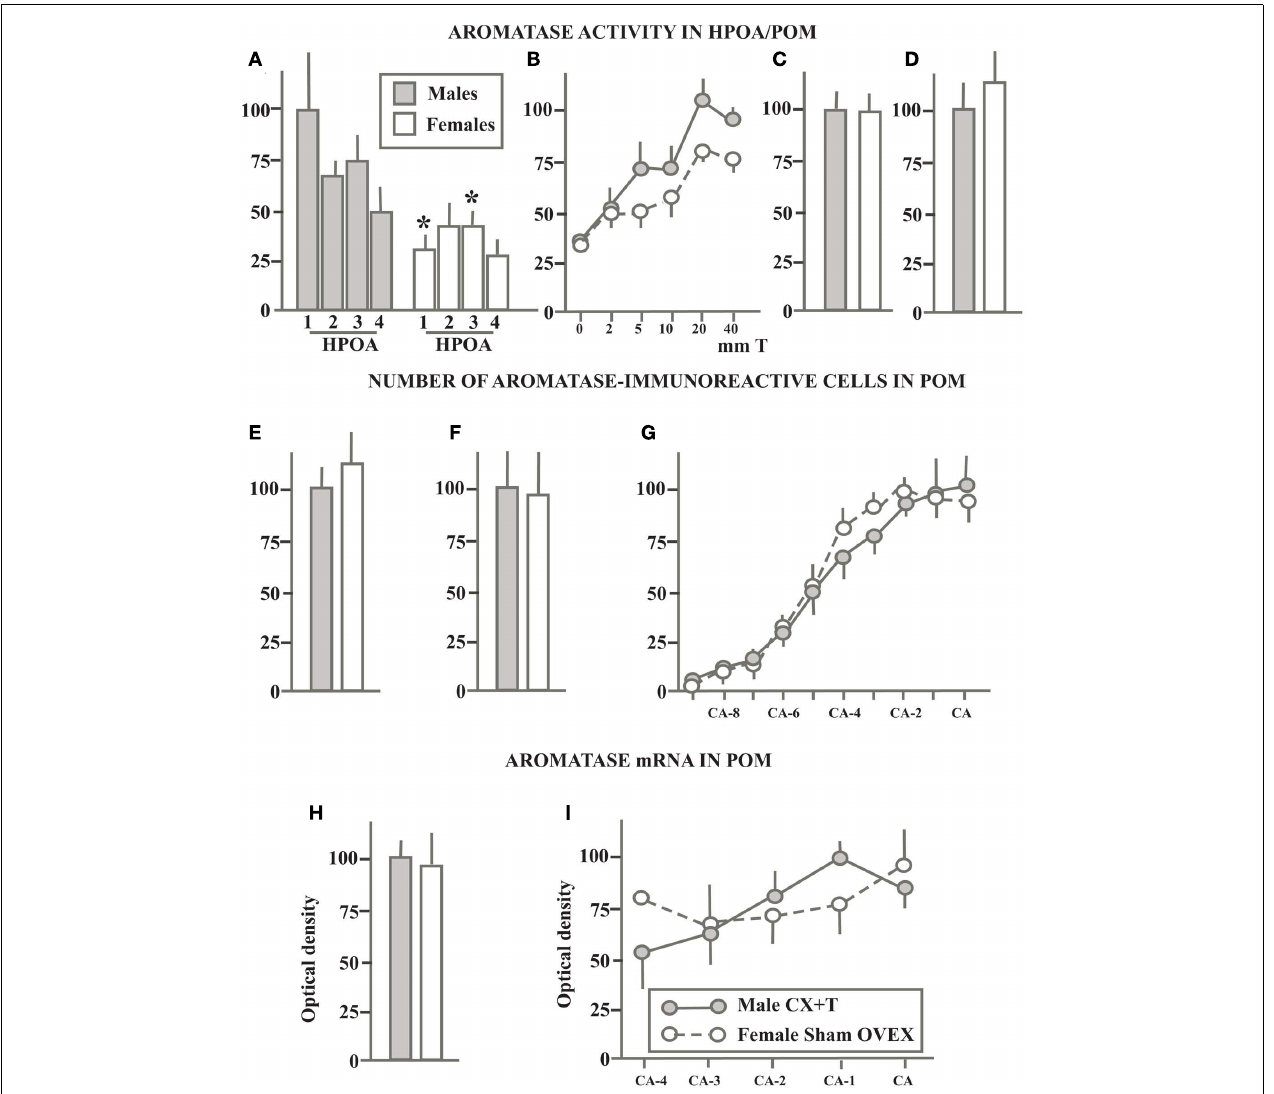
data are expressed as a percentage of the corresponding values in males that are set at 100% to allow direct comparisons.When serial values were collected along the rostro-caudal axis of the POM, data are expressed as the percentage of the maximal values in males. See text for additional comparisons. Redrawn from data in Schumacher and Balthazart (1986) (A) , Balthazart et al. (1990c) (B) , Balthazart et al. (1990e) (C) , Cornil et al. (2011) (D) , Foidart et al. (1994a) (E) , Balthazart et al. (1996b) (F,G) ,Voigt et al. (2011) (H,I)